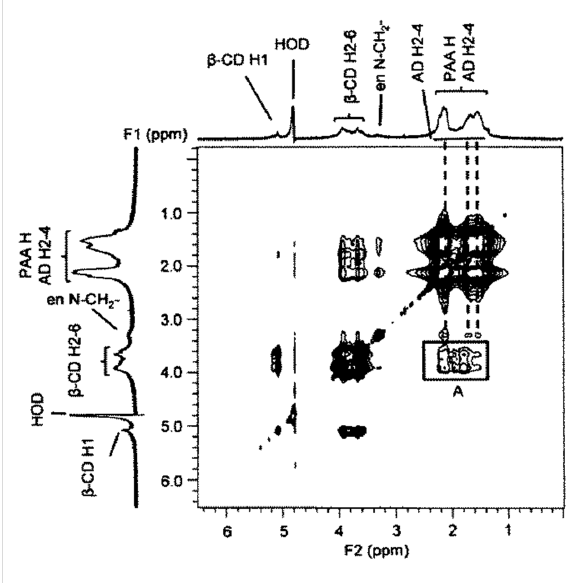
Figure 5: 2D NOESY 1 H NMR spectrum of 0.44 wt % PAA β -CDen ([ β - CDen] = 2.0 × 10 − 3 mol dm − 3 ) and 0.60 wt % PAAADen ([ADen] = 2.0 × 10 − 3 mol dm − 3 ) in D 2 O Na 2 HPO 4 /KH 2 PO 4 buffer at pD 7.0 and I = 0.10 mol dm − 3 at 298.2 K. The cross-peaks in box A are